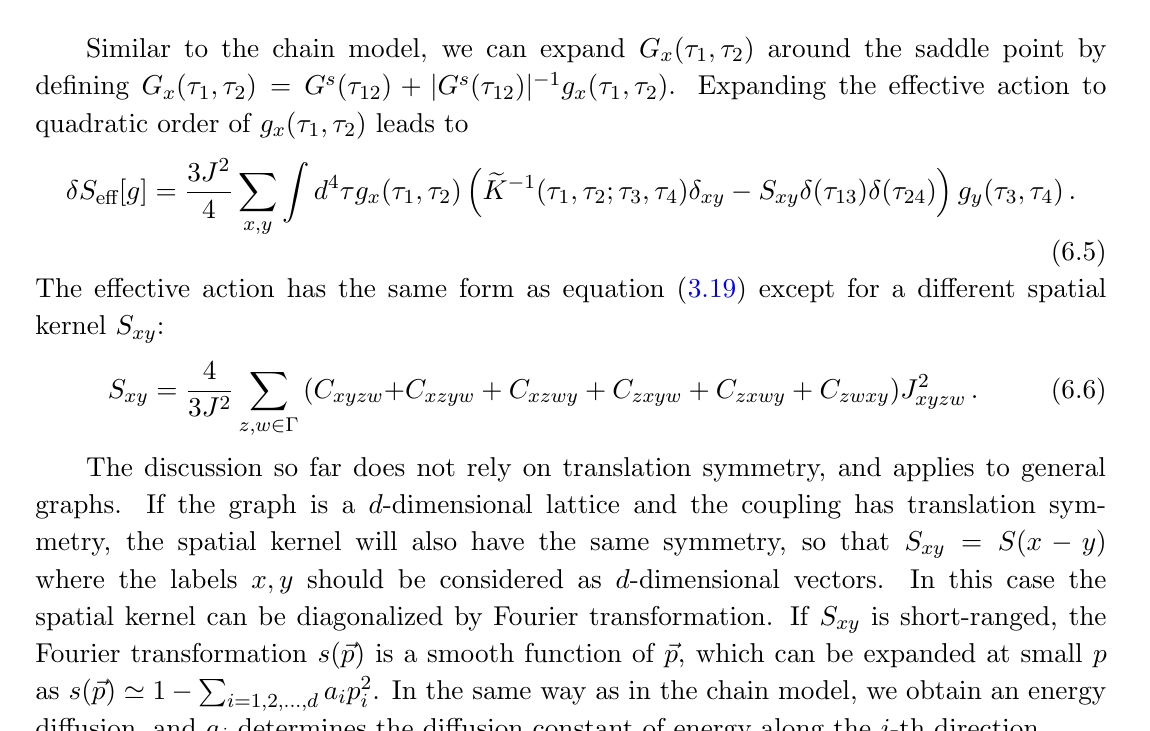
Figure 10. (a) A typical \watermelon" diagram for the general model. Just like SYK model and the (1 + 1) (cid:0) d chain model, in the general model the coupling J xyzw is also diagonal, such that only fermions with the same (cid:13)avor and spatial coordinate are connected under random average of disorder (cid:12)elds (dashed line). (b) A typical ladder in the generalized model. One needs to sum over all possible z and w in the middle to get the ladder kernel K xy